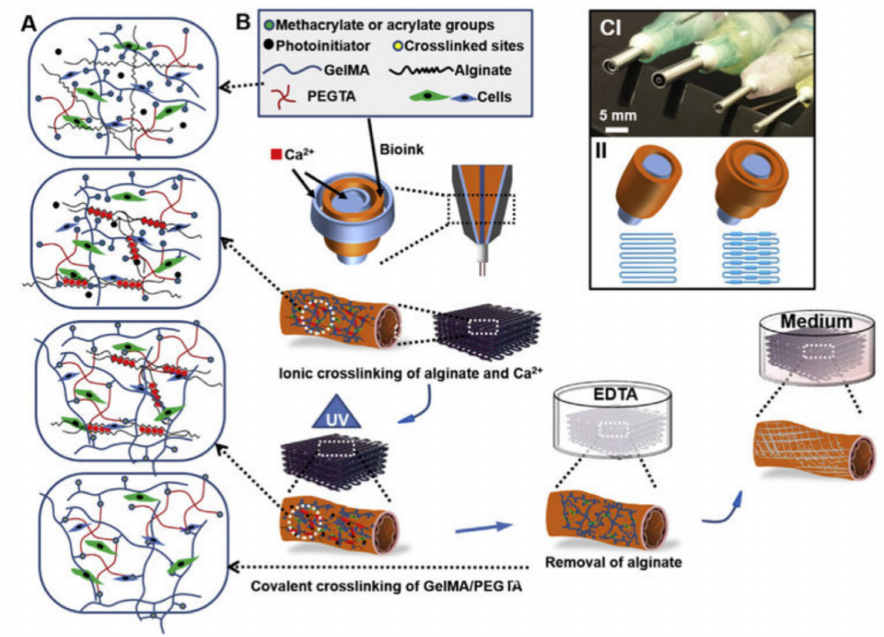
Figure 1. Three-dimensional printing-based design of perfusable vascular construct using crosslinked- bioink. ( A ) Graphical presentation of crosslinking processes of the bioinks, where alginate, GelMA, and PEGTA are ionically and covalently crosslinked, respectively, upon exposure to CaCl 2 solu- tion and UV light. ( B ) Schematic representation of the procedure for bioprintingperfusable hollow tubes with the cell-encapsulating blend bioink and subsequent vascular formation. ( C ) The de- signed multilayered coaxial nozzles and schematic diagram showing fabrication of perfusable hollow tubes with constant diameters and changeable sizes. (GelMA: Gelatinmethacryloyl; PEGTA: 4-arm poly(-ethylene glycol)-tetra-acrylate].) (Reproduced with permission from